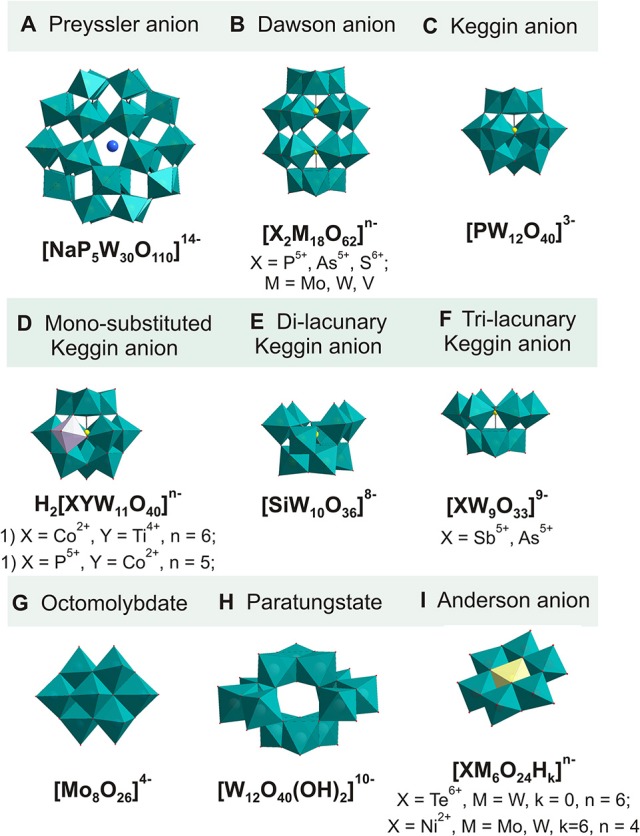
Polyhedral representation of key POM structures tested in this study. (A) Preyssler structure [NaP5W30O110]14− (Jeannin et al., 2007); (B) Dawson structure [X2M18O62]n− (X = P5+, As5+, S6+; M = Mo, W, V) (e.g., Contant et al., 2007); (C) α-Keggin structure [PW12O40]3− (Phillips, 1950); (D) mono-substituted Keggin structure [H2XYM11O40]n− [X = Co2+, Y = Ti4+, n = 6 (Kraus et al., 2005); X = P5+, Y = Co2+, n = 5 (Komura et al., 1976)]; (E) di-lacunary γ-Keggin structure [SiW10O36]8− (Téazéa et al., 2007); (F) tri-lacunary α-Keggin structure [XW9O33]9− (X = Sb5+, As5+) (Tourné et al., 1973); (G) octomolybdate [α-Mo8O26]4− (Klemperer, 2007); (H) paratungstate [W12O40(OH)2]10− (Evans and Rollins, 1976); (I) Anderson structure [XM6O24Hk]n− (X = Te6+, M = W, k = 0, n = 6 Schmidt et al., 1986; X = Ni2+, M = Mo, W, k = 6, n = 4 (Rozantsev et al., 2009; Gumerova et al., 2015). Color code: all addenda MO6 octahedra, green polyhedra; heteroatom X, yellow spheres or polyhedra; Na in (A), blue sphere; (C), black spheres; CoO6 and TiO6 in (D), pink polyhedra.